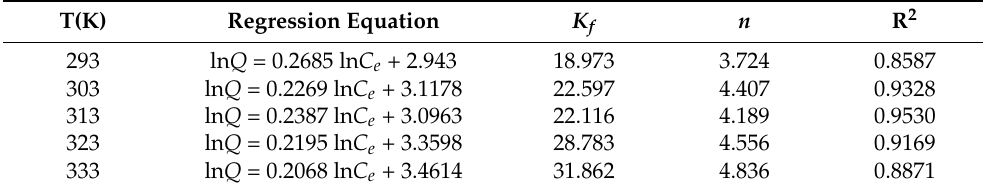
Table 5. Freundlich constants for the adsorption of methyl orange onto